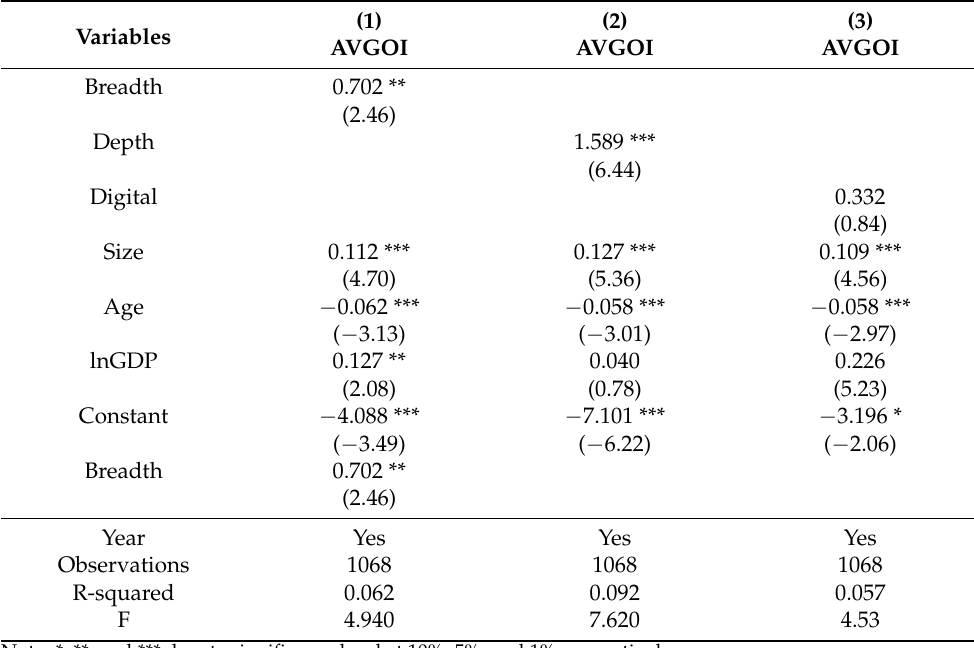
Table 5. Regression results of sub-dimensional digital inclusive finance